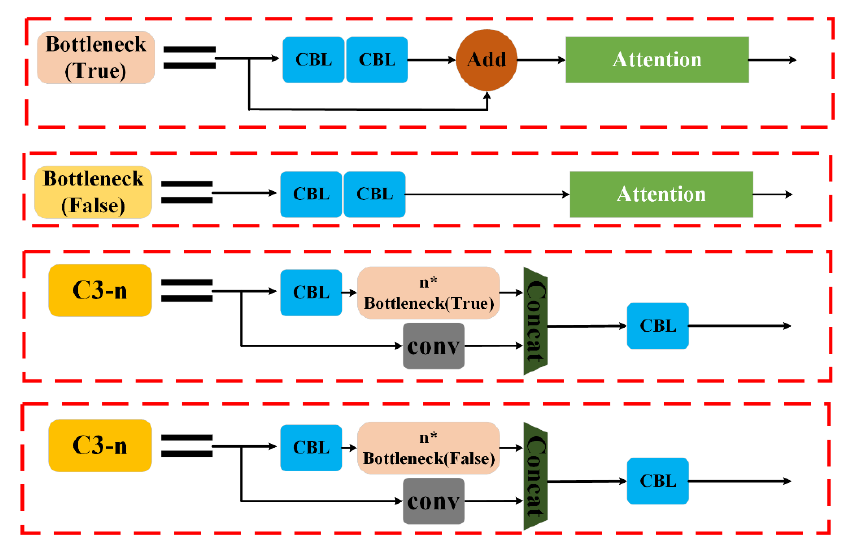
Figure 12. Schematic diagram of the location of attentional mechanisms.